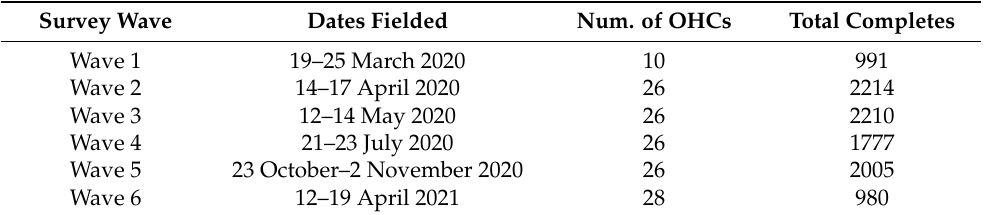
Table 1. Survey wave sample size, number of OHCs included, dates fielded, and completed responses. Survey Wave Dates